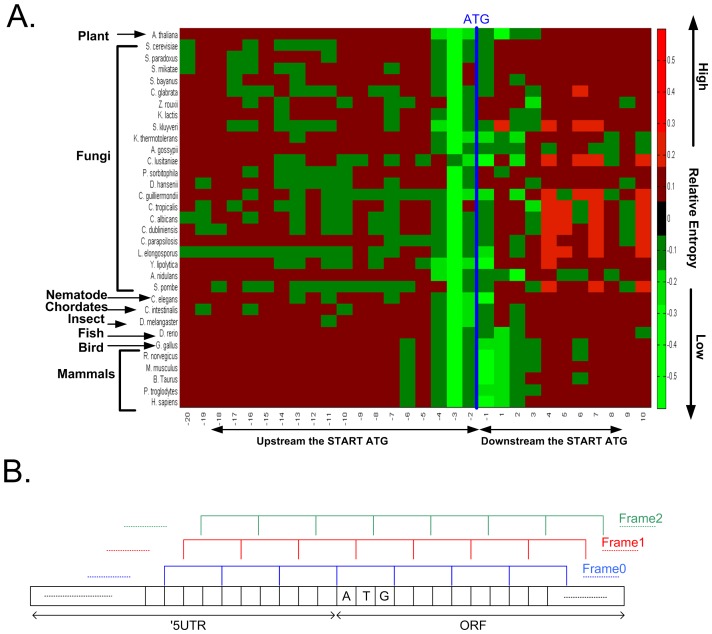
A. The relative entropy of the nucleotide distribution near the start ATG for 33 eukaryotes (see details in the Methods section), organized according to their evolutionary distance.High entropy denotes a non-conserved nucleotide distribution at a particular position. The most conserved position is −3 (three nucleotides upstream the START codon), but positions −2 and −1 are also relatively conserved. As can be seen different phylogenic groups exhibit different nucleotide conservation patterns. B. The definition of the three frames analyzed in this study.